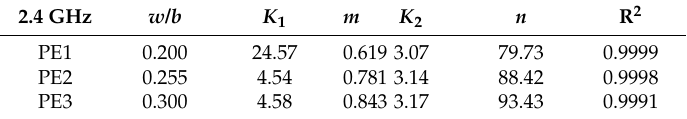
Table 6. Regression coefficients and goodness of fits for measured data at 2.4 GHz.